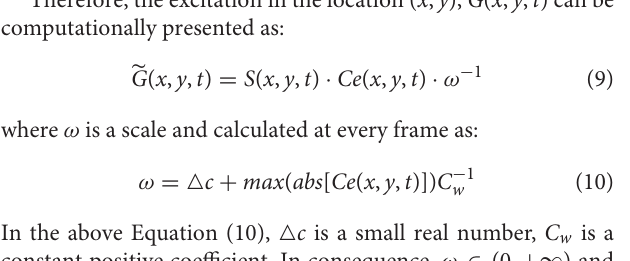
FIGURE 3 | the field of view into 16 equal segments. Each unit consists of a 37.5 deg receptive field, 15 deg of which are overlapped with each neighbor. Blue and green arcs illustrate the way neighboring receptive fields overlap. (B) The proposed neuromorphic structure based on MLG1s for looming spatial localization. In total, sixteen identical PNNs make up the proposed MLG1s